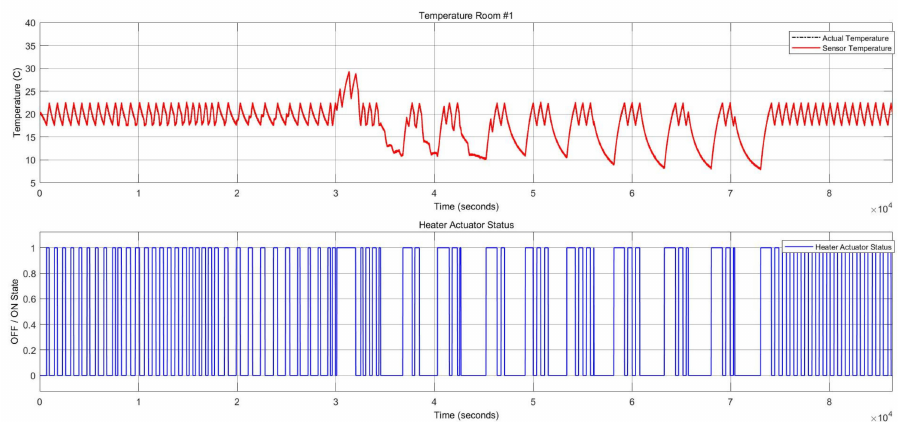
Figure 17. Heater actuator statuses vs. temperature sensor variations in the case of an intermittent fault with ten repetitions in the HVAC system.